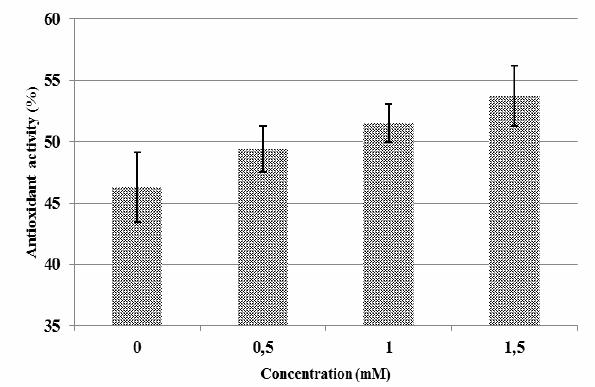
Fig. 6. Effect of different concentrations of SA on antioxidant